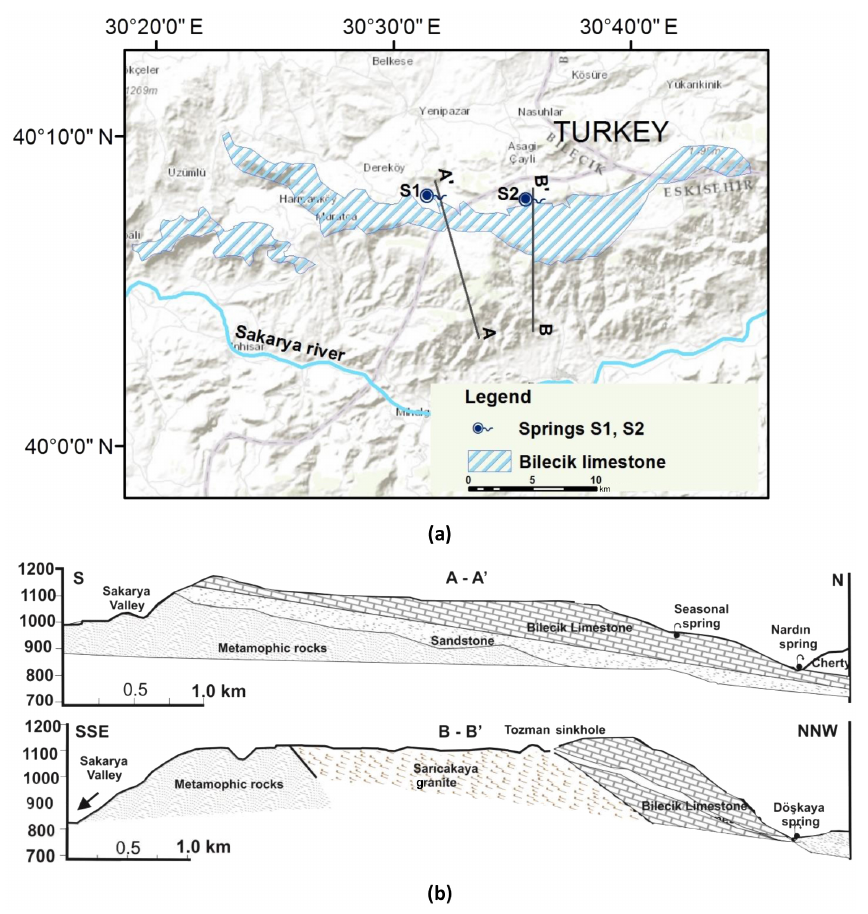
Figure 2. (a) Location map of Bilecik limestone (Jkb), (b) the geological cross section of Döskaya (S1) and Nardin (S2) springs (modified by Aydin et al.,